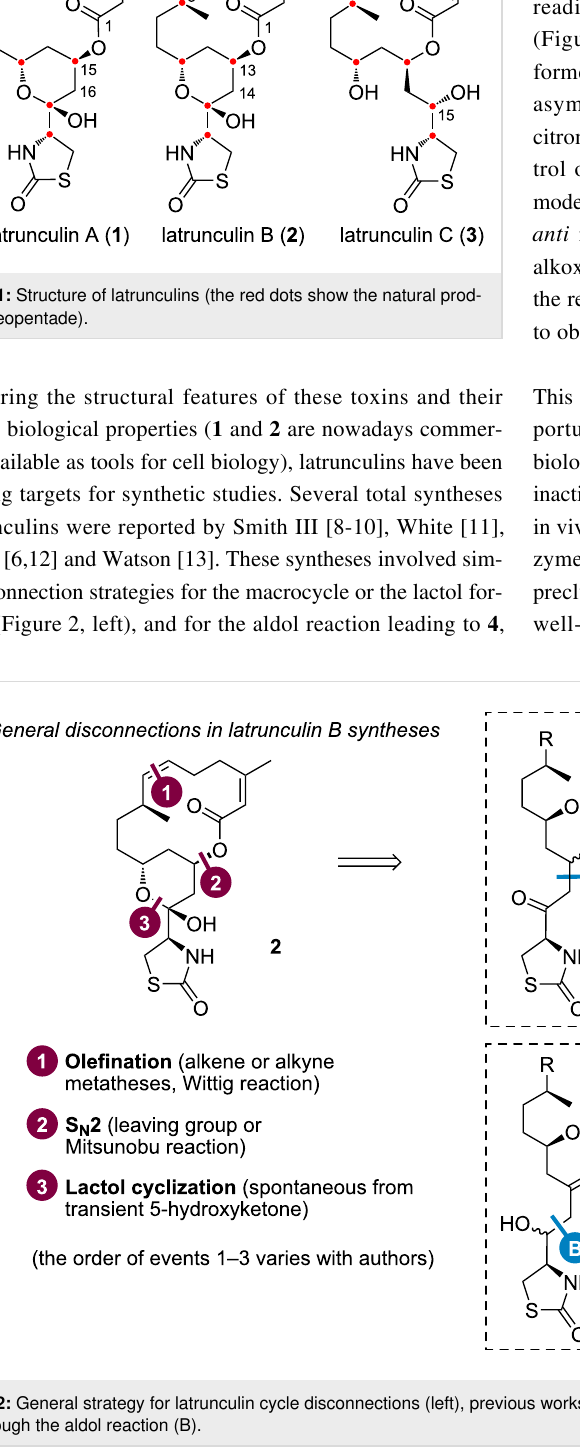
Figure 2: General strategy for latrunculin cycle disconnections (left), previous works towards linear precursor 4 (A), and our alternative disconnection of 7 through the aldol reaction (B).